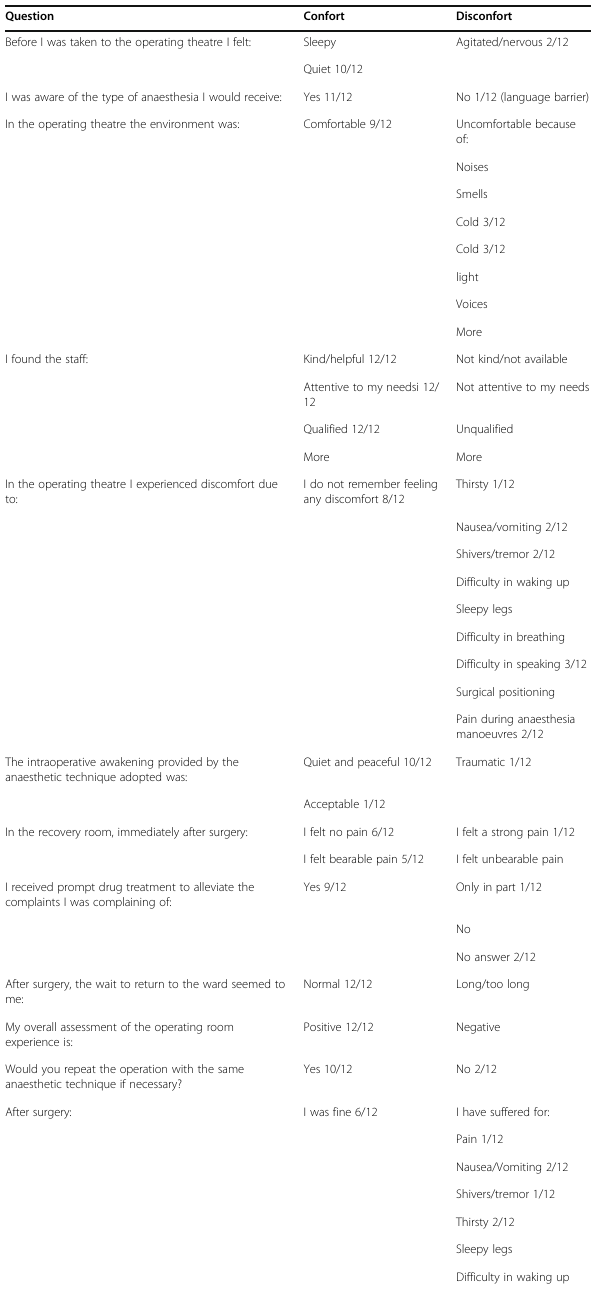
Table 1 (abstract 70). See text for description